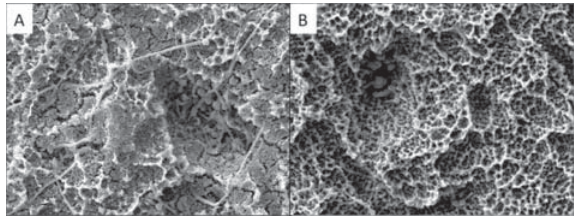
of sandblasted/acid-etched (SLA) surfaces